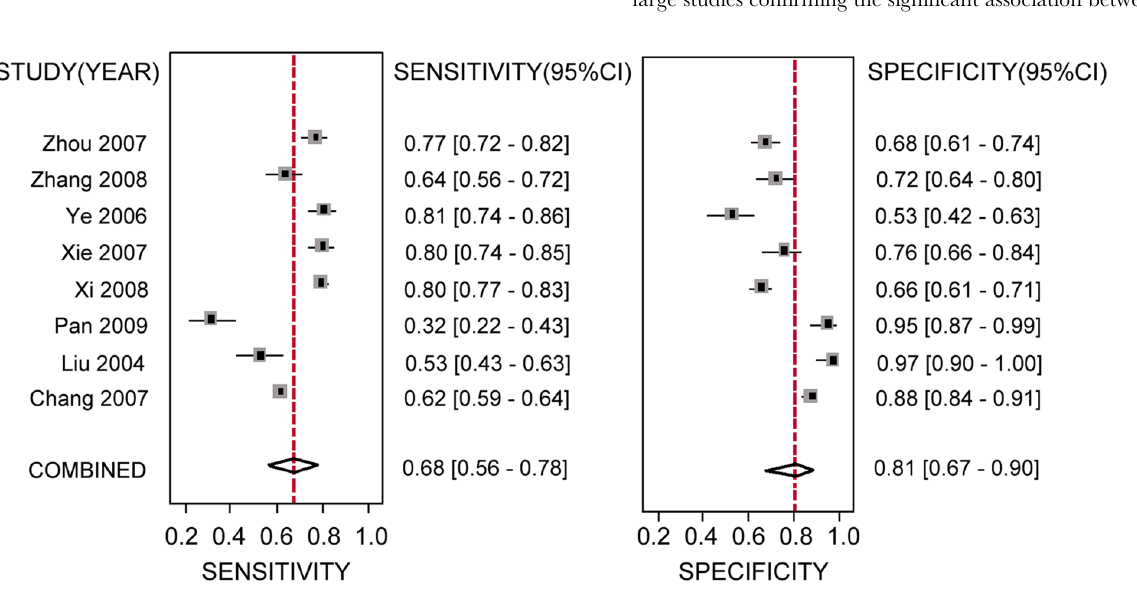
the summary ROC curves. Figure 3 and Figure 4 are the forest plot and the summary ROC curve for the TLC threshold of 1500 cells/mm 3 for predicting a CD4 cell count , 350 cells/mm 3 , respectively. According to the criteria adopted in our study, the optimal TLC threshold was found to be 1500 cells/mm 3 with a pooled sensitivity of 0.68 (95% CI, 0.56–0.78) and a pooled specificity of 0.81 (95% CI, 0.67–0.90), as shown in the second row in Table 3.